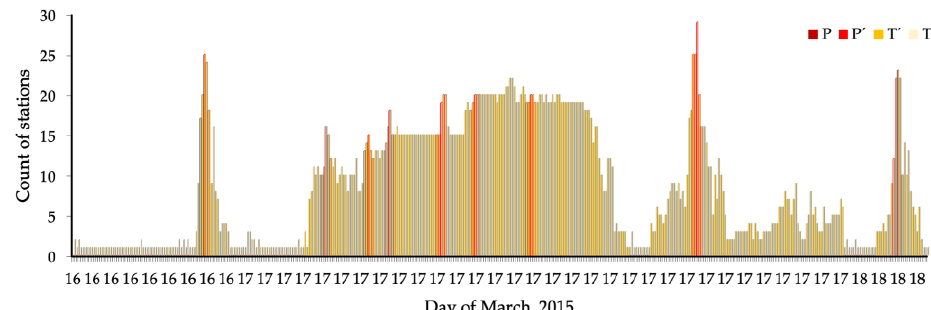
Figure 2. Plot of subsets of Formula (9).